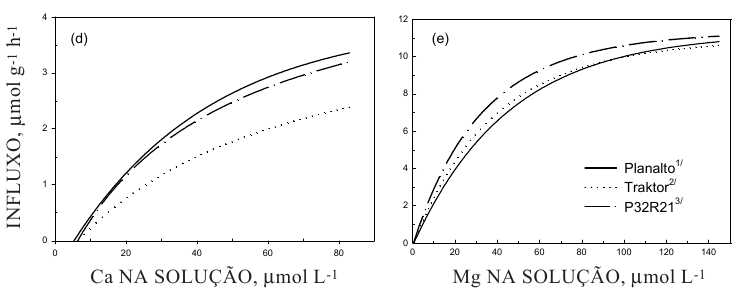
Figura 1. Taxa de influxo de N-NO 3- (a), P (b), K (c), Ca (d) e Mg (e) de genótipos de milho de acordo com a concentração de nutrientes na solução. (1) Variedade de polinização aberta; (2) Híbrido duplo; (3) Híbrido